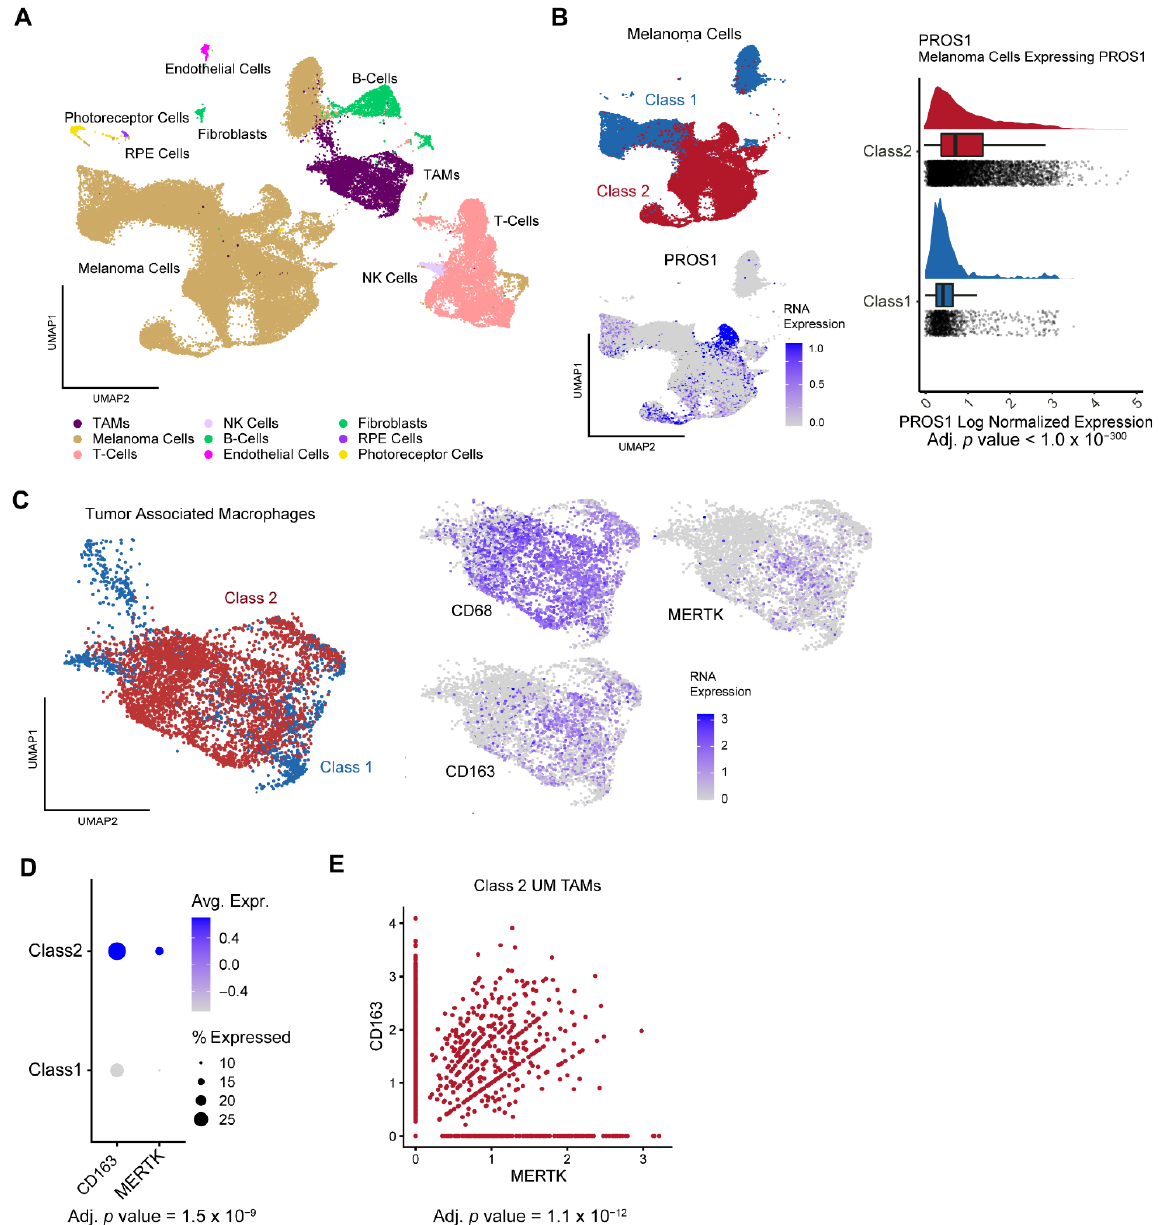
Figure 2. Single-cell RNA sequencing analysis of PROS1 and MERTK in uveal melanomas. ( A ) UMAP dimensionality reduction plot of 59,915 neoplastic and non-neoplastic cells from 11 uveal melanoma samples, with cell types indicated in the legend. ( B ) Left: UMAP plot of the 42,230 uveal melanoma cells in the dataset, with colors indicating gene expression profile (GEP) class 1 ( blue ) and class 2 ( red ). Right: corresponding UMAP plot demonstrating log normalized expression of PROS1 , as indicated by heatmap. ( C ) Left: UMAP plot of the 5053 monocytes/macrophages in the dataset, with colors indicating GEP class 1 ( blue ) and class 2 ( red ) of the tumors from which the cells were derived. Right: corresponding UMAP plots demonstrating log normalized expression of CD68 , CD163, and MERTK , as indicated by a heatmap. ( D ) Dot plot demonstrating MERTK expression in monocytes/macrophages with respect to GEP class status of the tumors from which the cells were derived. ( E ) Scatter plot demonstrating association between expression of MERTK and CD163 in monocytes/macrophages from class 2 tumors.